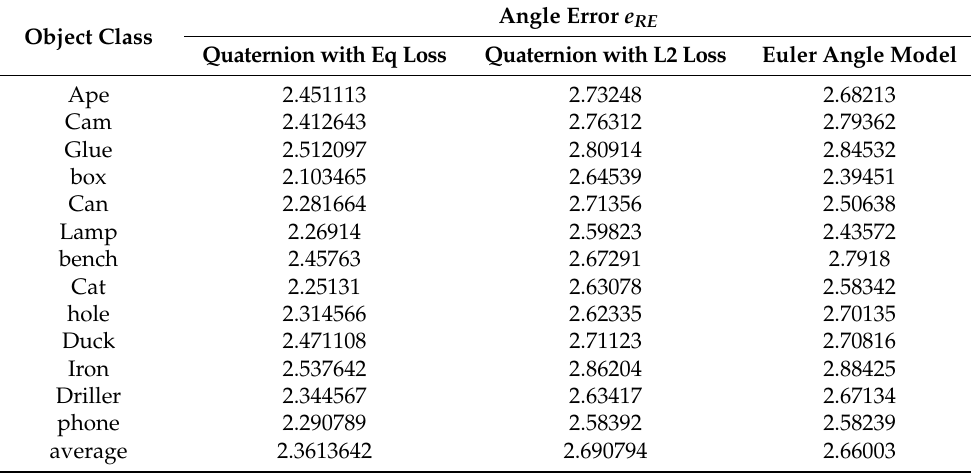
Table 3. Comparison of angle error e RE with the different loss